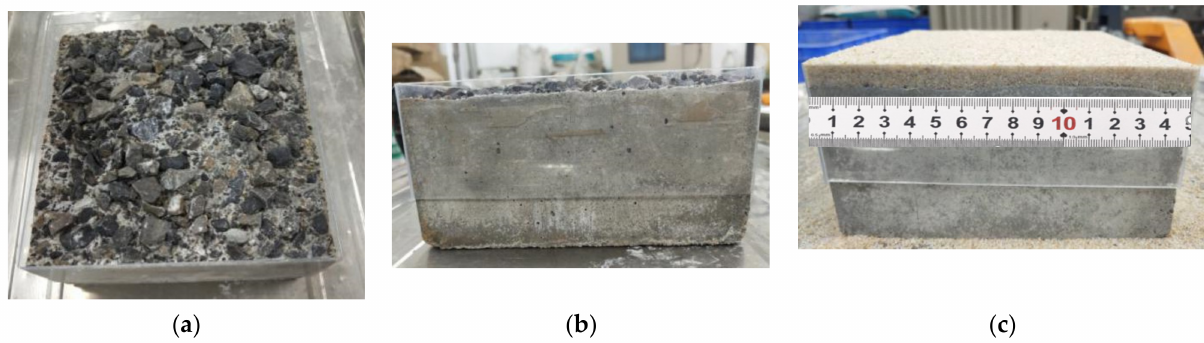
Figure 3. Roughness measuring of surface in sectional dimension of 150 mm × 150 mm: ( a ) specimen preparation; ( b ) fit to plastic board; ( c ) sand replacement.